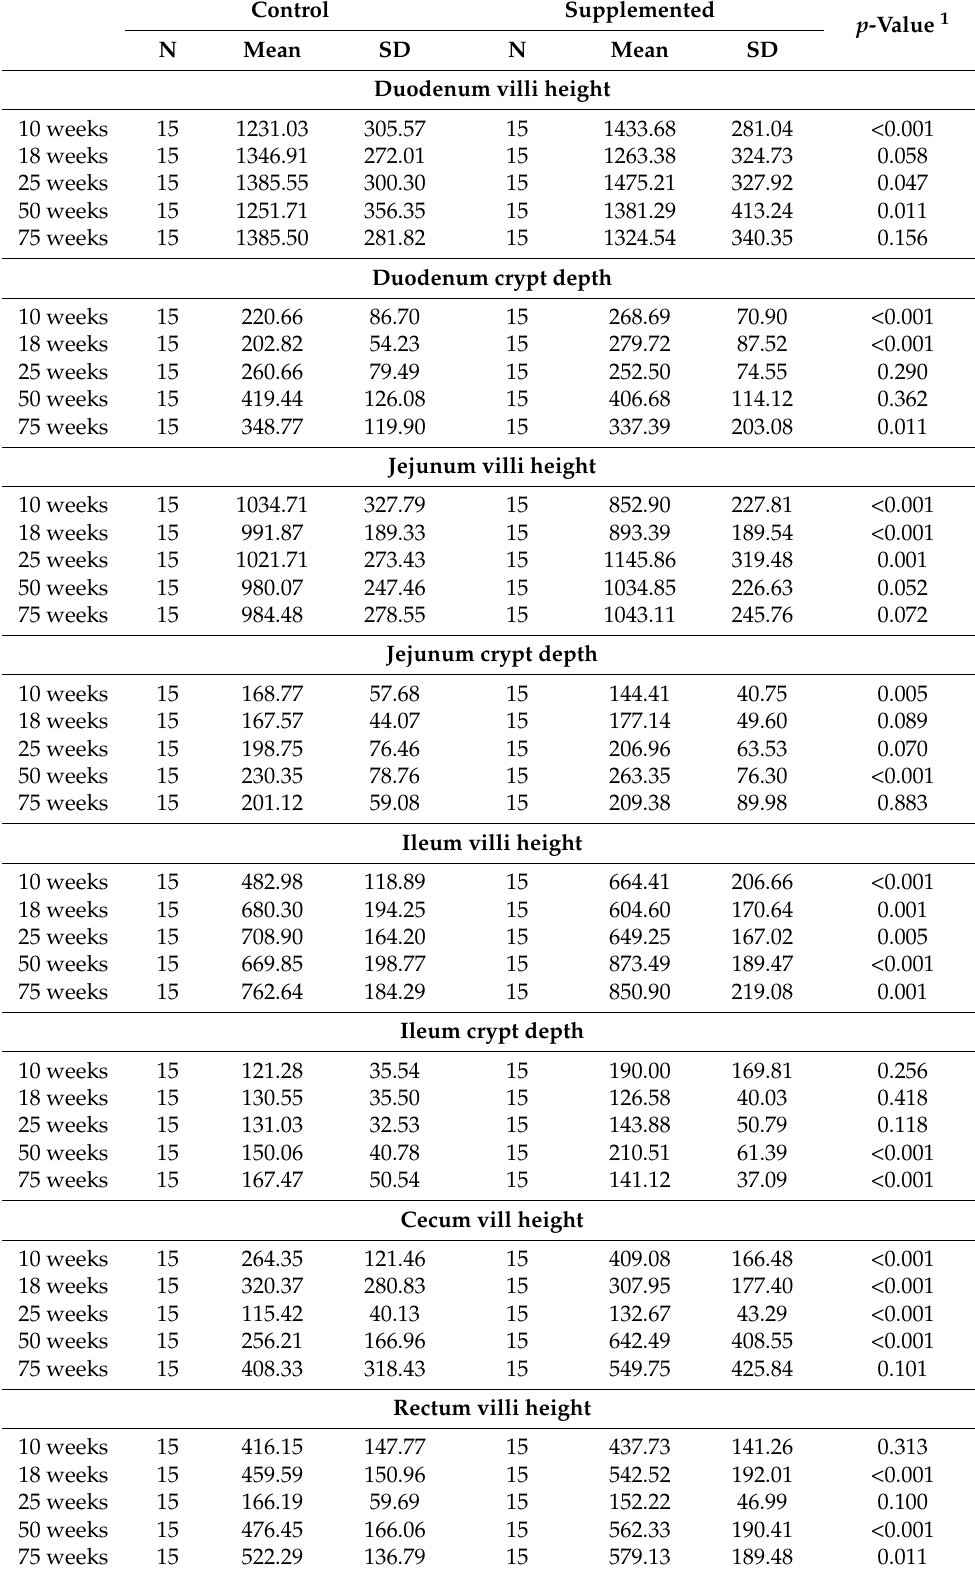
Table 6. Histomorphometric results in the intestinal segments. Number of samples (N), mean values (Mean), standard deviation (SD) and p -value are detailed per age